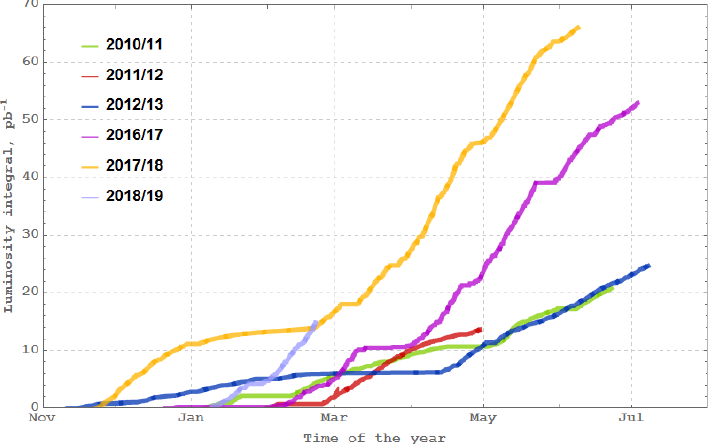
Fig. 8 CMD-3 recorded luminosity